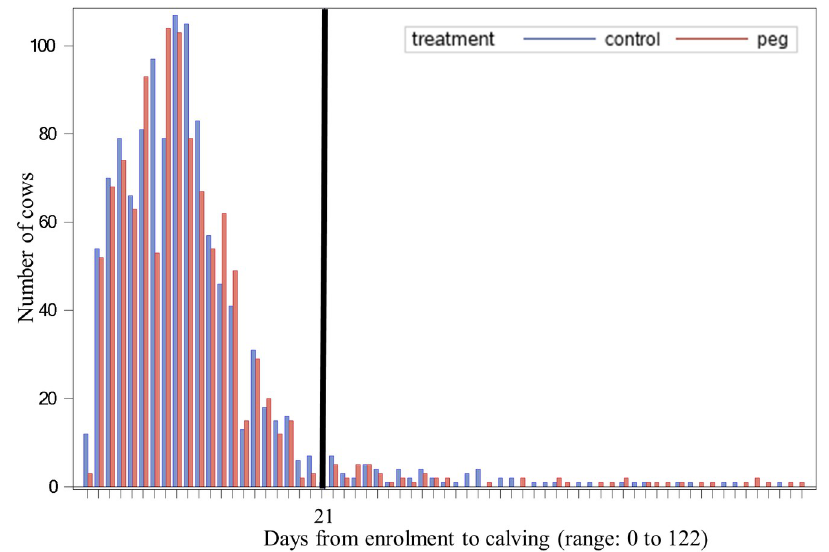
Fig 1. Number of cows by interval from enrollment to calving (day 0). Ninety six percent of the animals were enrolled within 21 days (black line) before calving. Control = 1,114; PEG = 1,039. Note: some values in the range have frequencies of 0 so are not represented in the